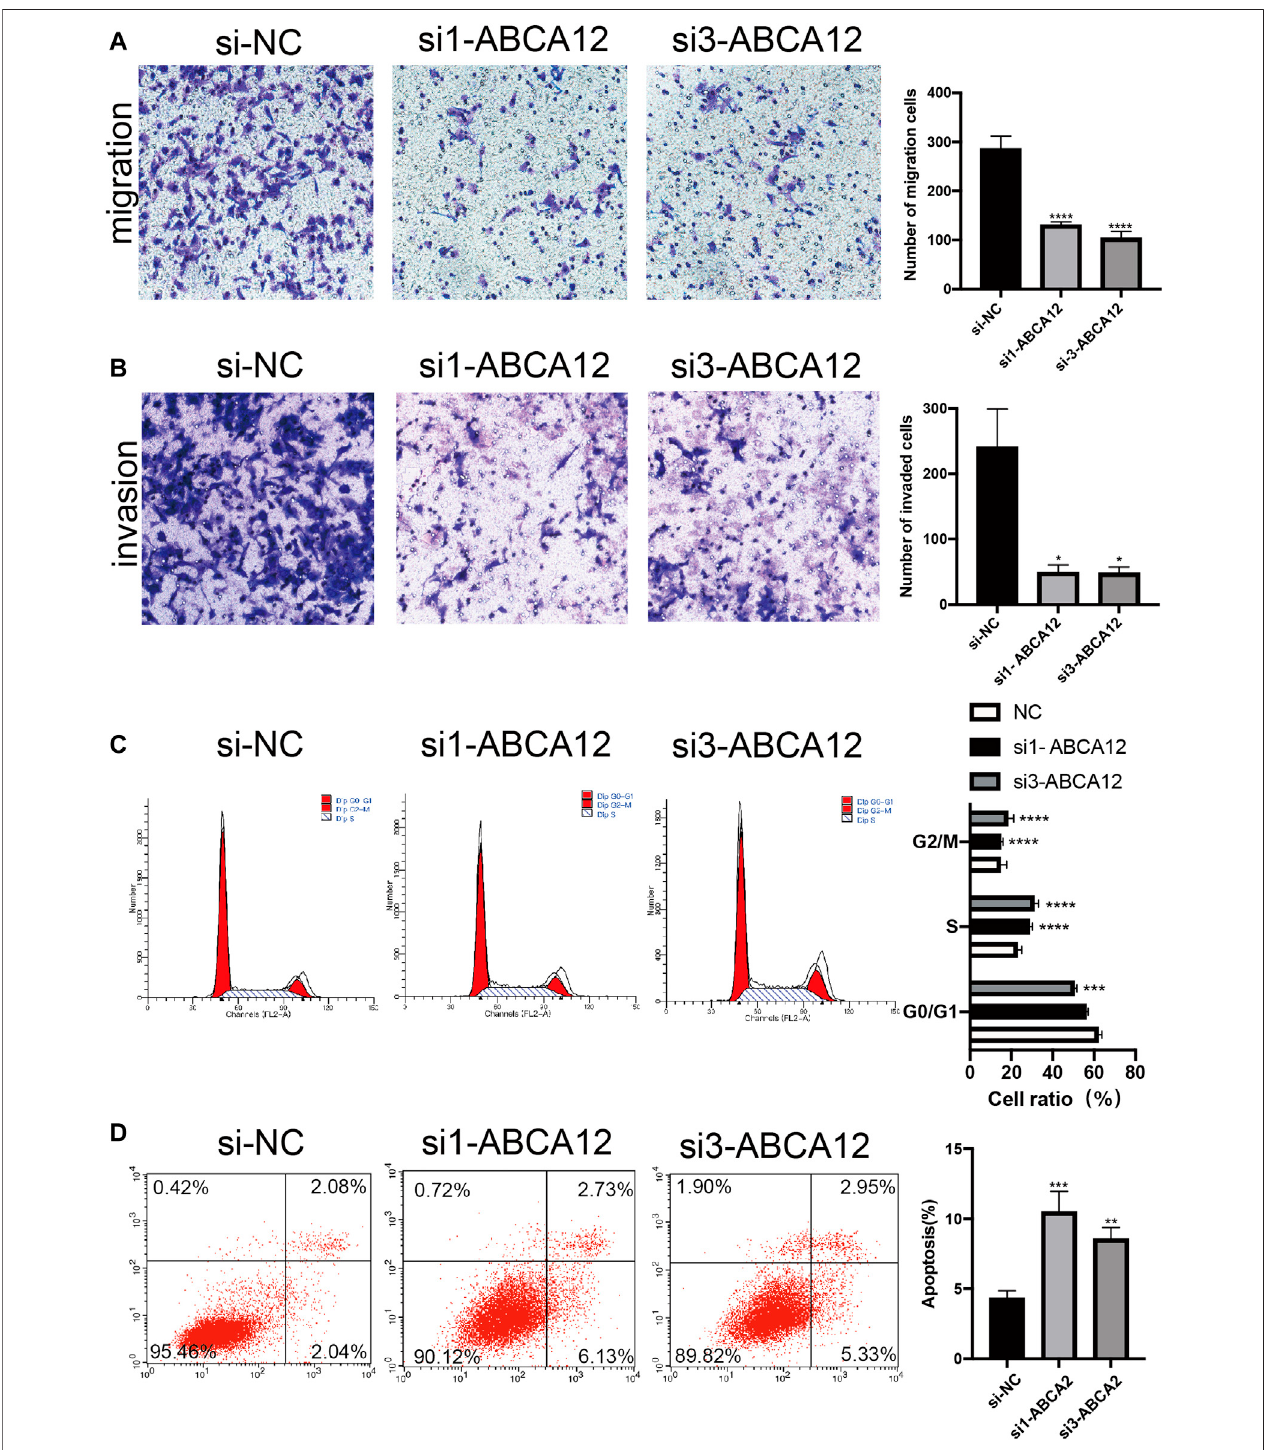
FIGURE 5 | Transwell and fl ow cytometry of SW1990 cells after ABCA12 knockdown. (A) Transwell assays showed that ABCA12 knockdown reduced the migrationcapacityofpancreaticcancercells. (B) Transwellassayswithmarigelprovedthattheinvasionabilityoftheknockoutgroupwasdecreased. (C) Flowcytometry showedthatthenumberofG0/G1phasecellsdecreasedandthatofSphasecellsincreasedafter ABCA12 wasinhibited. (D) Flowcytometryshowedthattheapoptosis level was signi fi cantly increased after ABCA12 was knocked down.